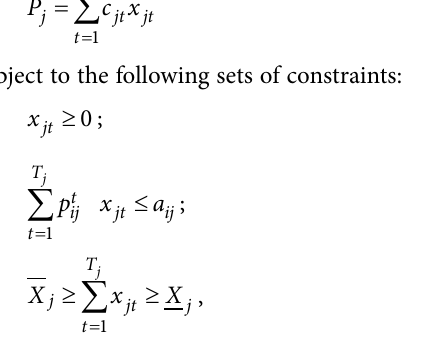
Table 4. The results of model experimental computations (1)–(4) j x jt